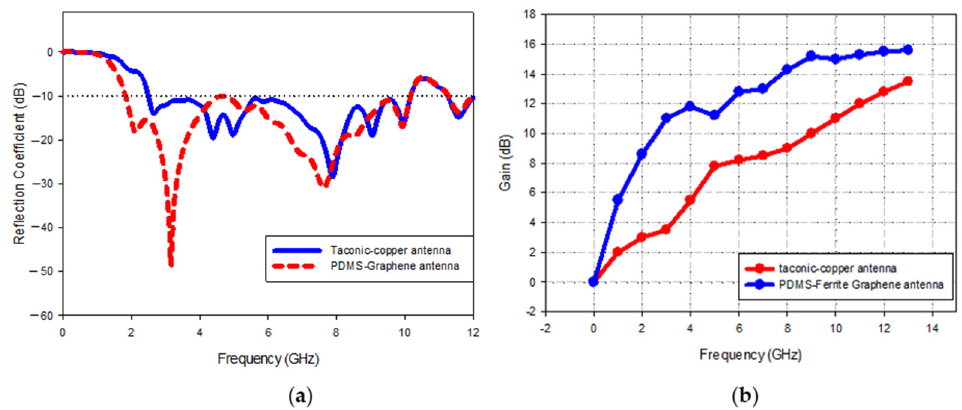
Figure 12. Magnetite PDMS Graphene Array and Copper − Taconic Sensor; ( a ) operated bandwidth, ( b ) gain.